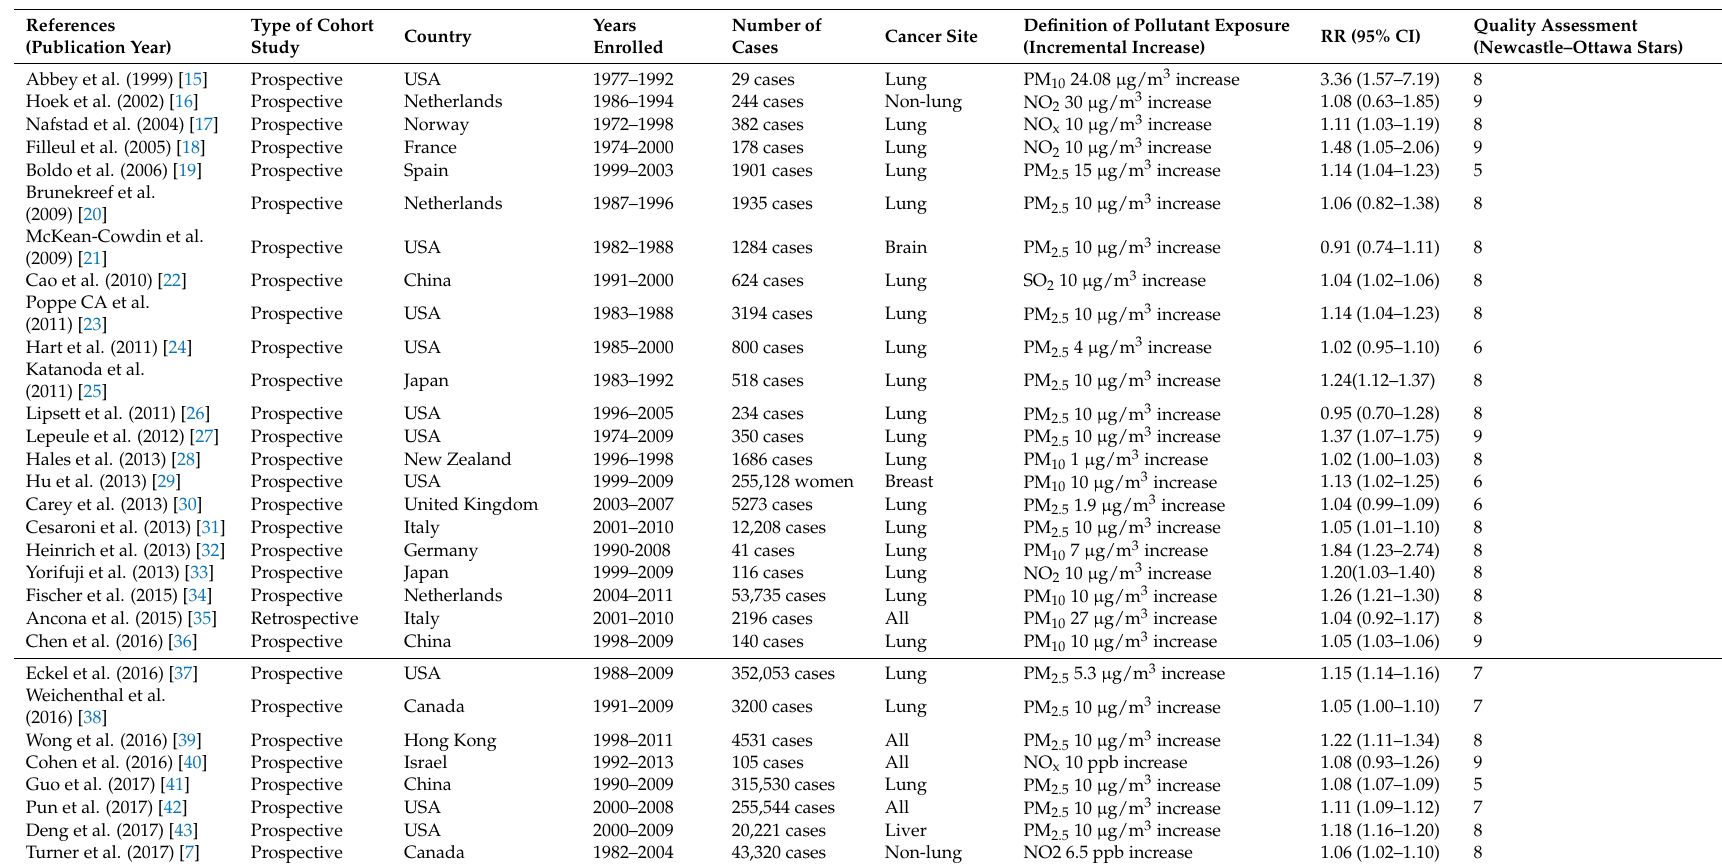
Table 1. General characteristics of the cohort studies included in the final analysis (n =